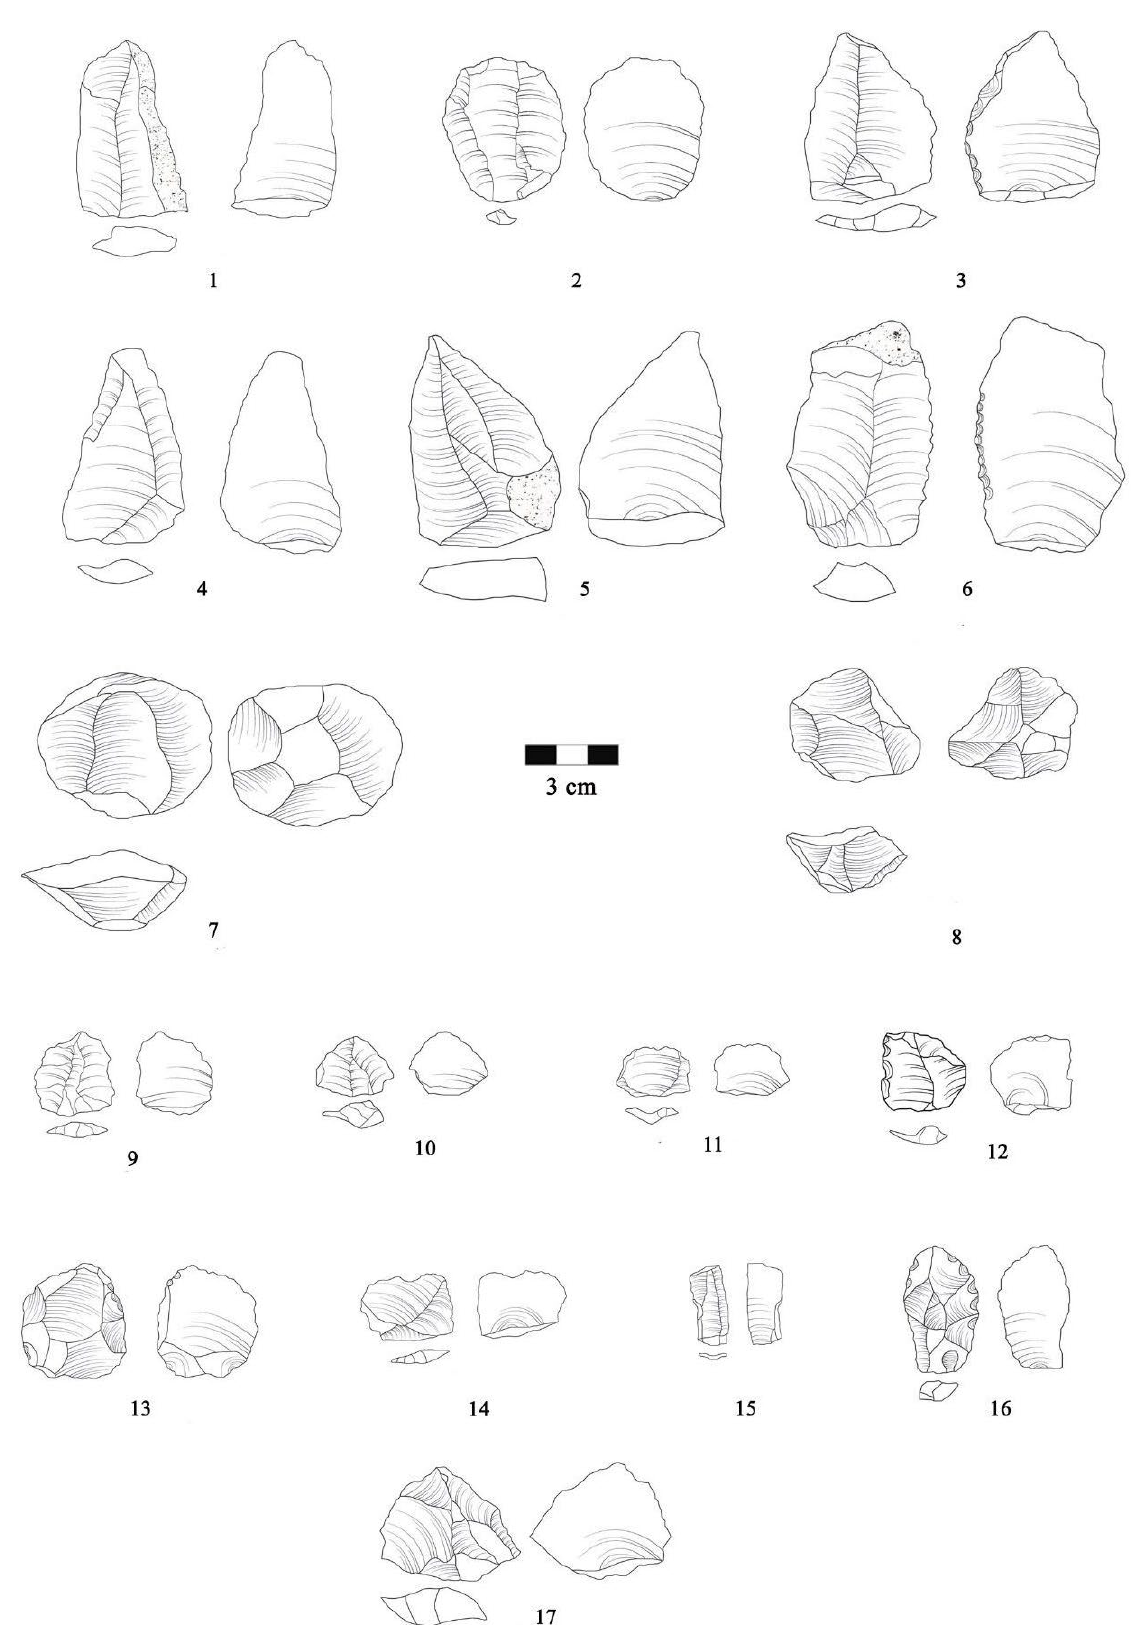
Figure 7: Lithics from GOT 1-S: basalt [1-7] volumetric points [1, 4], Levallois flake [2] and Levallois retouched point [3], point [5], retouched flake [6], Levallois core [7]; quartz [8-17], Levallois flakes [9-14, 17], bladelet [15], Levallois core Journal of Lithic Studies (2021) vol. 8, nr. 1, 29 p. DOI: https://doi.org/10.2218/jls.6530